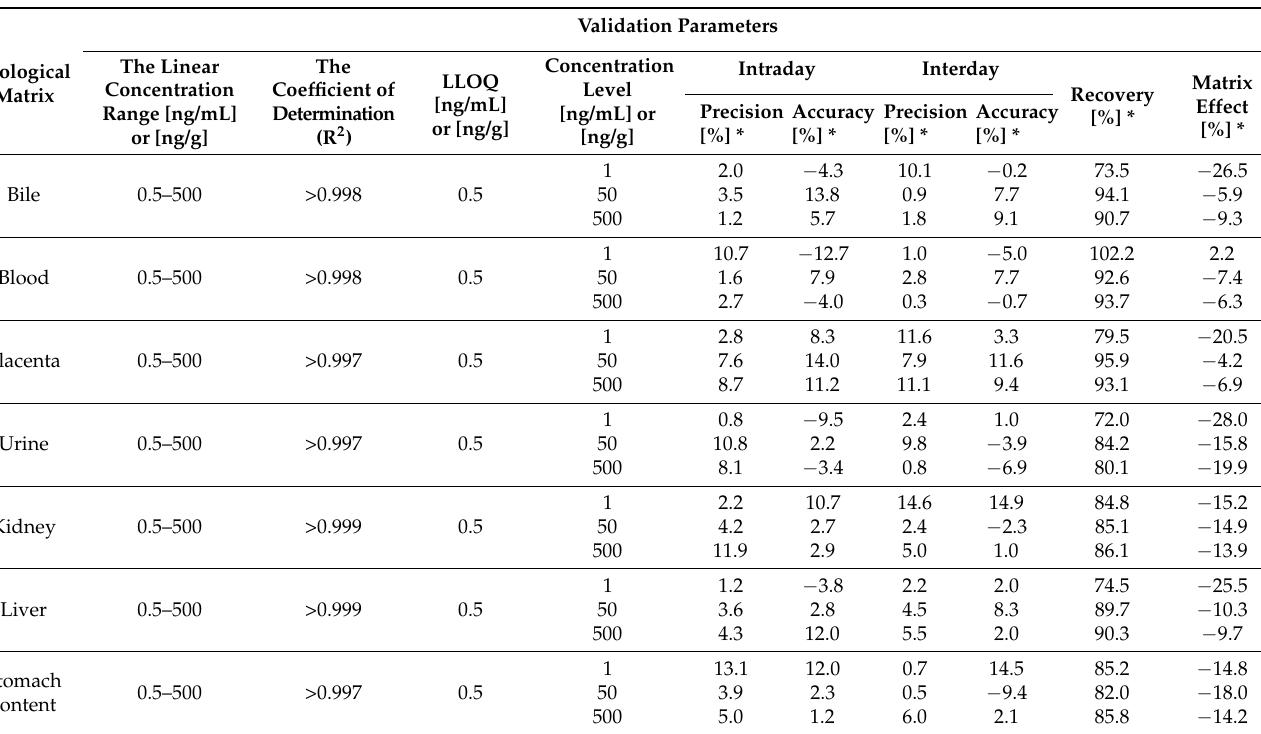
Table 2. Recoveries, matrix effects, intra- and interday precision, and accuracy of diclofenac from postmortem samples using